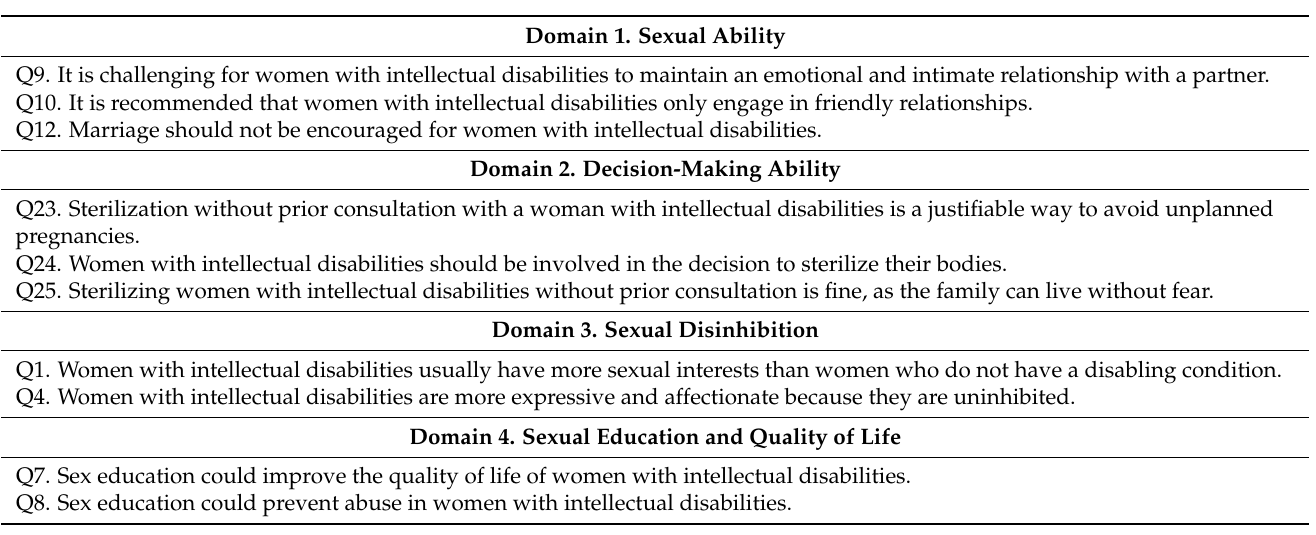
Table 3. Final scale on the social attitudes of sexuality of women with